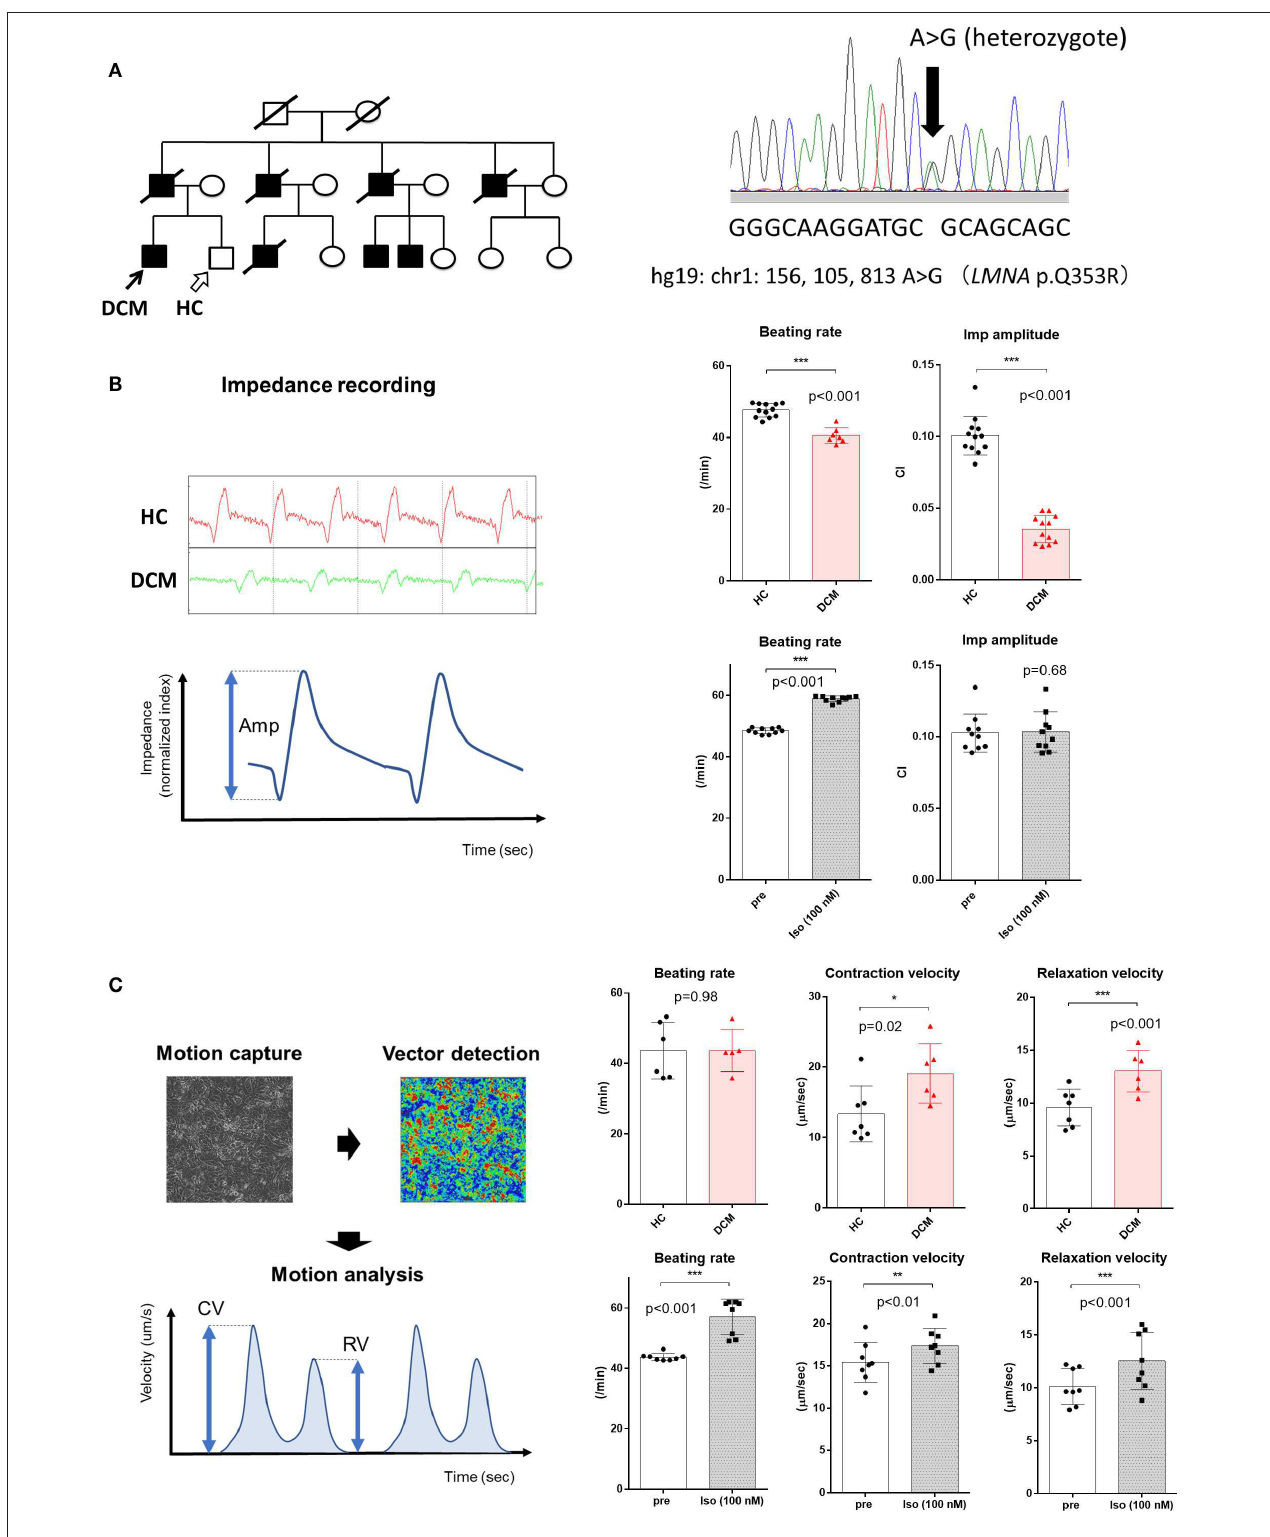
FIGURE 1 | Contractile properties of LMNA -mutant DCM hiPSCMs assessed in the 2D sheet approach. (A) (Left) Pedigree of a familial DCM cohort with a heterozygous mutation in LMNA . Black arrow indicates the DCM patient; white arrow indicates the healthy sibling who served as a healthy control (HC). (Right) Sanger